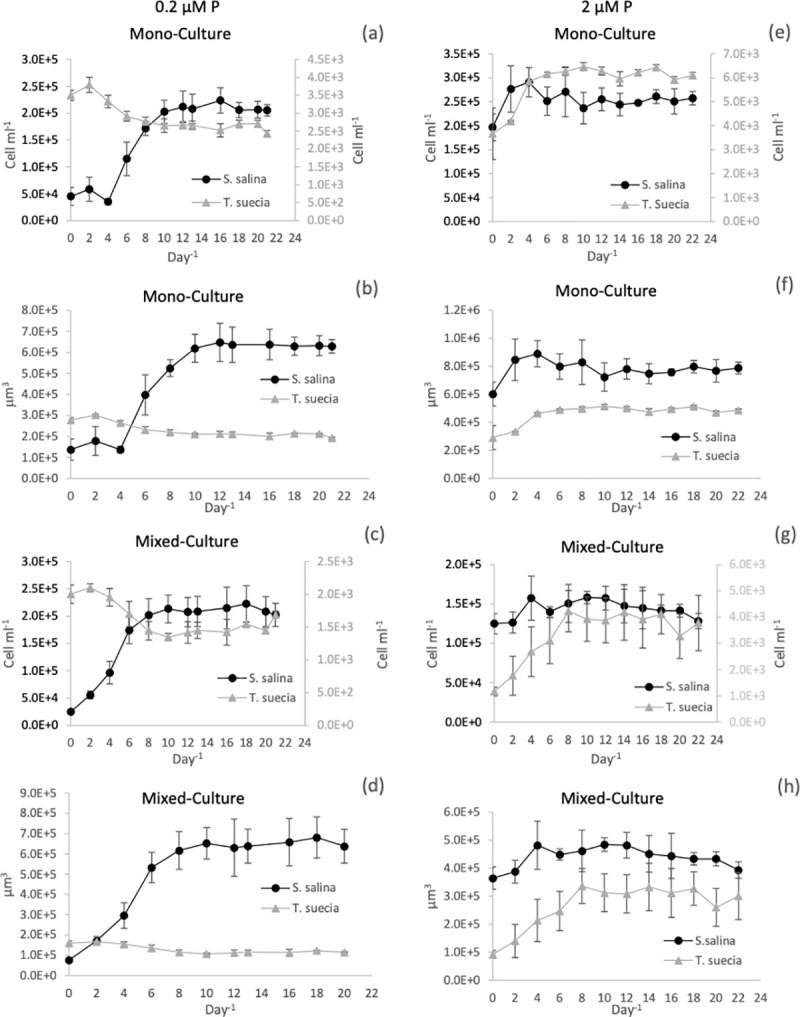
Total biomass for the chemostat experiments over time (Day-1) expressed as either cell ml-1 or total biovolume (μm3) for the mono-culture and mixed-culture experiments for S. salina (●) and T.suecica (▲), at 0.2 μM P, Figs (a-d) and 2μM (e-h).Cell numbers are expressed as cell ml-1 on the primary axis for S. salina and on the secondary axis for T.suecica (a, c, e and g). Cell numbers were converted to total biovolume (μm3) at 0.2μM P (Figs b and d) and 2μM P (Figs f and h). Error bars represent SEM.